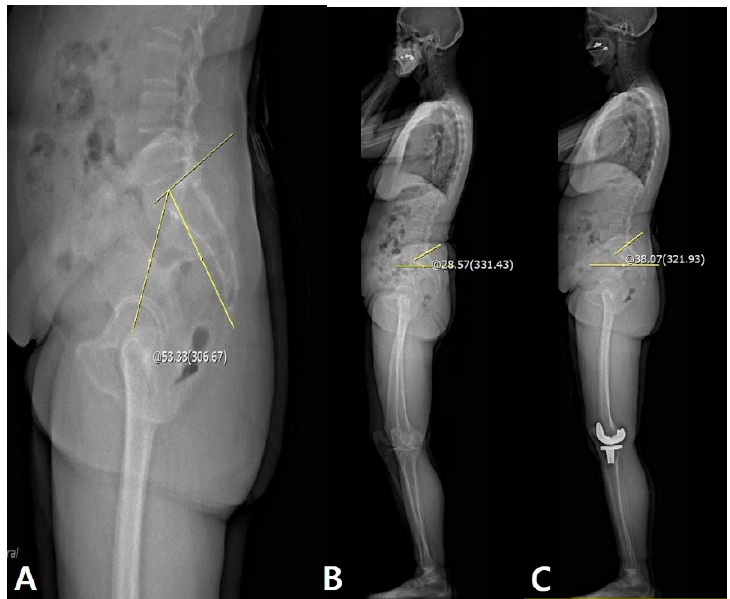
Figure 4. Patient with larger pelvic flexibility (PF) improved sagittal pelvic alignment, such as increased SS, after TKA. ( A ) Measurement of PF: 53.33°. ( B ) Measurement of preoperative SS: 28.57°. ( C ) Measurement of postoperative SS: 38.07°. The yellow line and circle are the measurement about pelvic incidence and sacral slope.